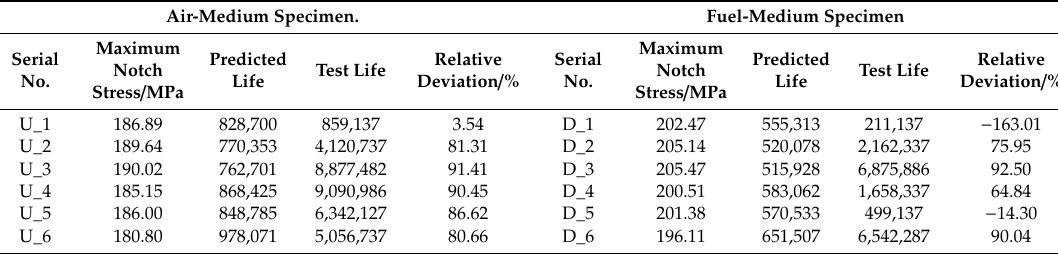
Table 10. Predicted life N 2 derived from simulated stress analysis.